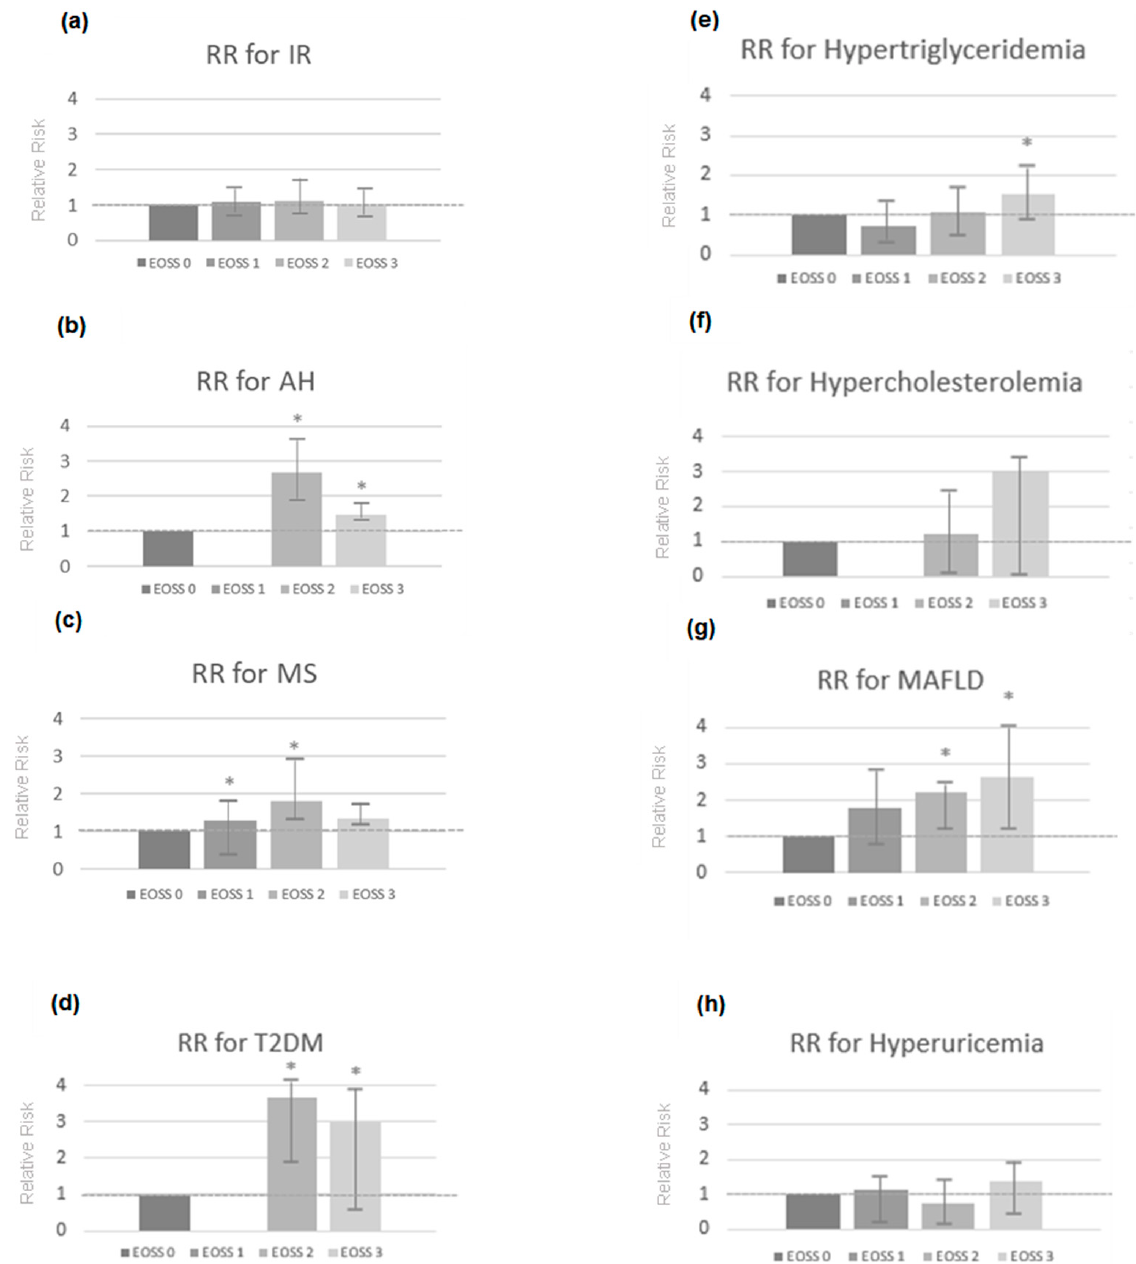
Figure 1. Association between Edmonton Obesity Staging System (EOSS) stage and risk of IR ( a ), AH ( b ), MS ( c ), T2DM ( d ), hypertriglyceridemia ( e ), hypercholesterolemia ( f ), MAFLD ( g ) and hyperuricemia ( h ) in the sample. * p ≤ 0.05. IR, insulin resistance; AH, arterial hypertension; MS, metabolic syndrome; T2DM, type 2 diabetes mellitus; MAFLD, metabolic-associated fatty liver disease; RR, relative risk. Cox proportional hazards